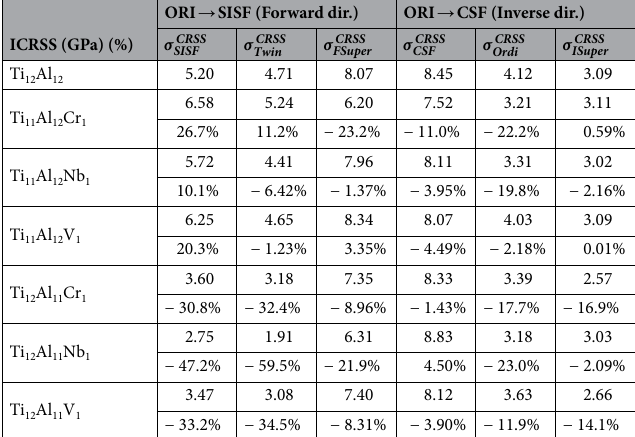
Table 3. ICRSS and the relative change compared with stoichiometric gamma TiAl.